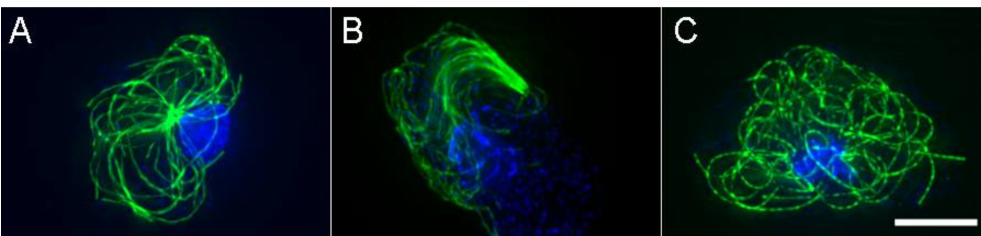
Figure 2. Variable interphase MT architecture. ( A ) Wild-type arrangement ( B ). Typical motile comet-like arrangement of MTs in cells with impaired dynein function. ( C ) Spaghetti-like MT pattern, in a cell where Kinesin-4 (Dd Kif8) function has been disrupted. Note here a loss of the distinctive radial MT pattern; even the centrosome position is non-distinct. MTs in green, Scale bar = 5 µ m.